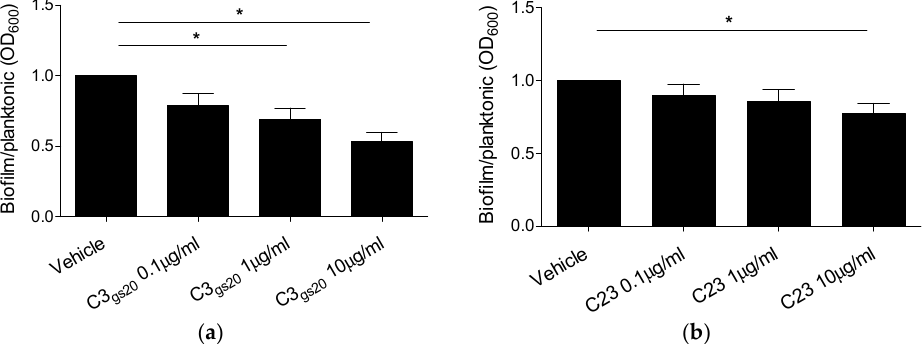
Figure 6. Effect of synthesized HS competitors on P. aeruginosa biofilm formation. P. aeruginosa strain AA43 was grown for 24 h at 37 °C either in the absence or presence of different concentrations of C3 gs20 ( a ) and C23 ( b ). Biofilm biomass was quantified by staining with crystal violet and absorbance measurements at OD 600 . Absorbance of planktonic bacteria in the culture medium was measured at OD 600. Results are expressed as the ratio between biofilm absorbance and planktonic bacteria absorbance normalized on the value obtained for AA43 treated with isotonic saline (vehicle). The data derive from three independent experiments in triplicate. Values represent the mean ± SEM. Statistical significance is indicated: * p < 0.05.